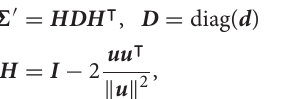
TABLE 1 | Model pruning hierarchy that helps highlight the contribution of boredom and curiosity in regulating agent’s exploration and perseveration.